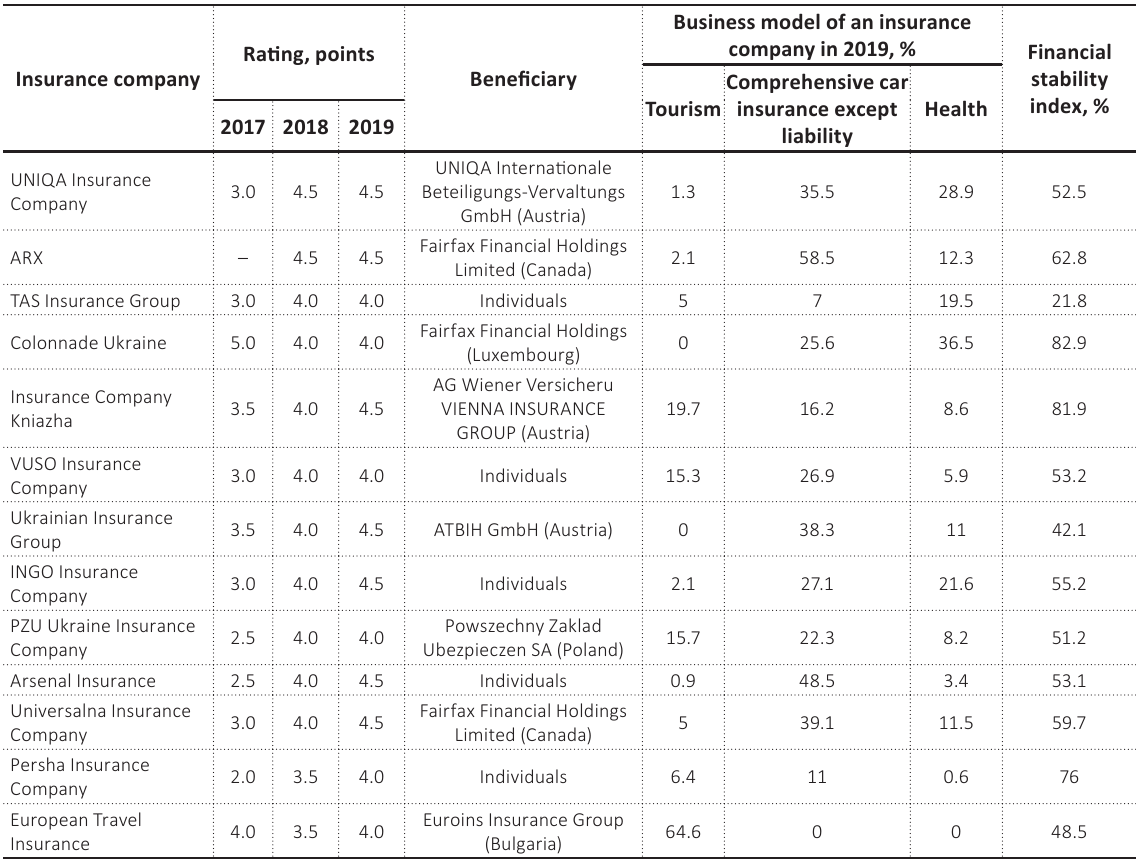
Table 1. Rating of Ukrainian insurance companies in 2017–2019 *